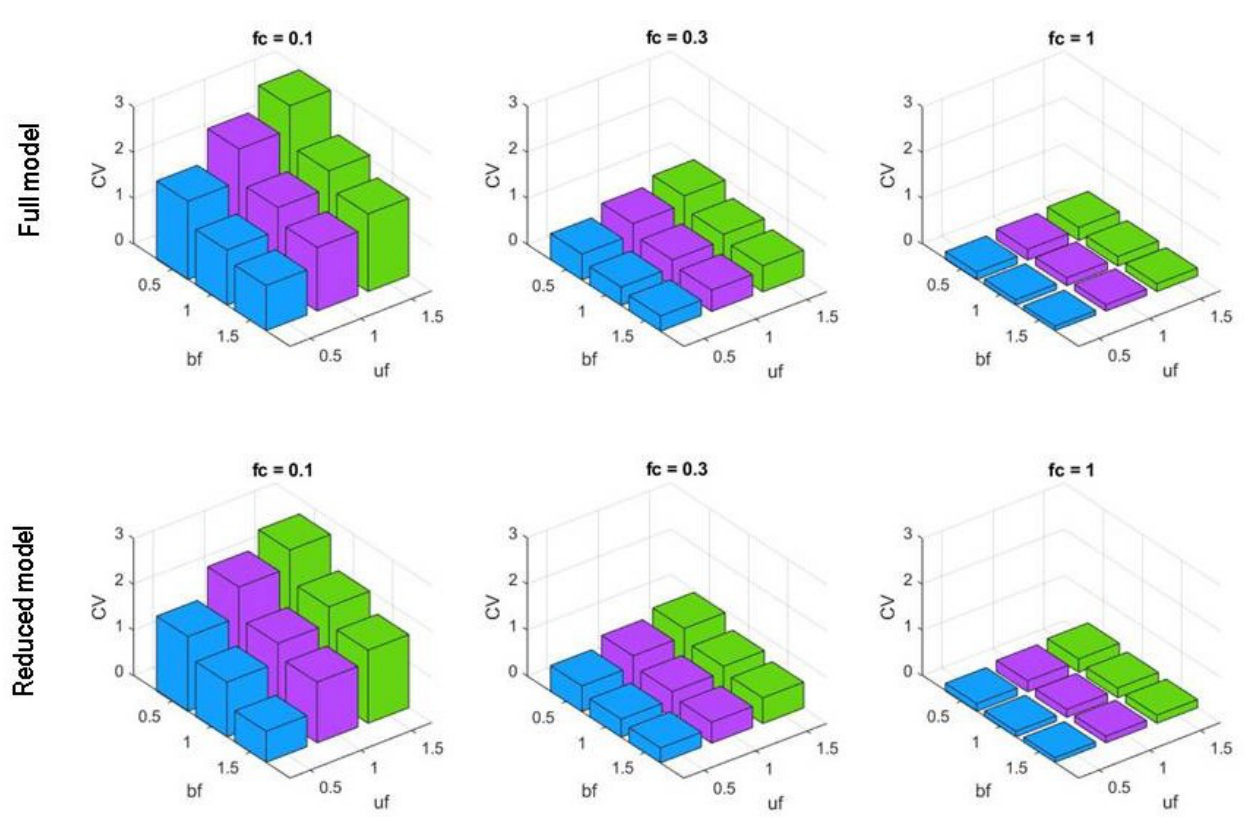
Figure 5. Bar graphs of pPhoAa coefficients of variation obtained by varying uf and bf with different external P i concentra- tions, fc ∈ { 0.1,0.3,1.0 } , in both full and reduced models. The lowest intrinsic noise levels correspond to low unbinding factors and high binding factors for the pPhoAa